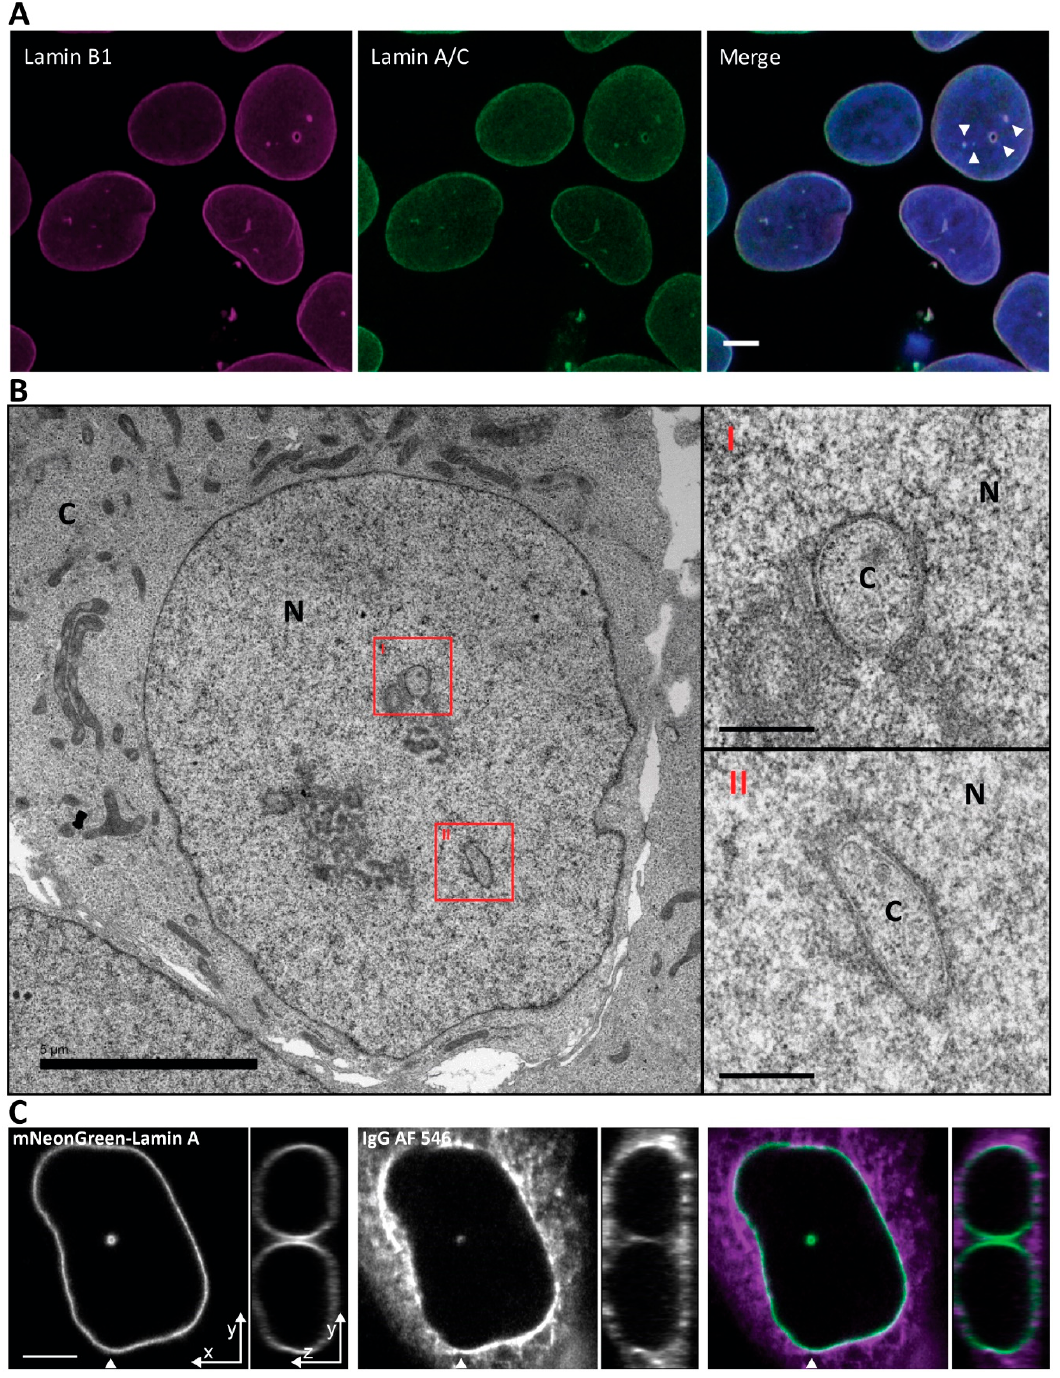
Figure 1. Nuclei of Ishikawa cells contain invaginations of the nuclear envelope forming a nucleoplasmic reticulum. ( A ) Ishikawa cells immunostained with anti-Lamin B1 and anti Lamin A/C. Scale bar 5 µm. ( B ) Electron microscopy micrograph of a high-pressure frozen Ishikawa cell. Scale bar is 5 µm for low magnification nucleus and 0.5 µm for high magnification insets. N, nucleus; C, cytoplasm. ( C ) Cytoplasmic loading by IgG AF 546 to visualize the cytoplasmic core of the invagination. Arrowhead indicates position of orthogonal projection in the panels to the right. Scale bar 5 µm.